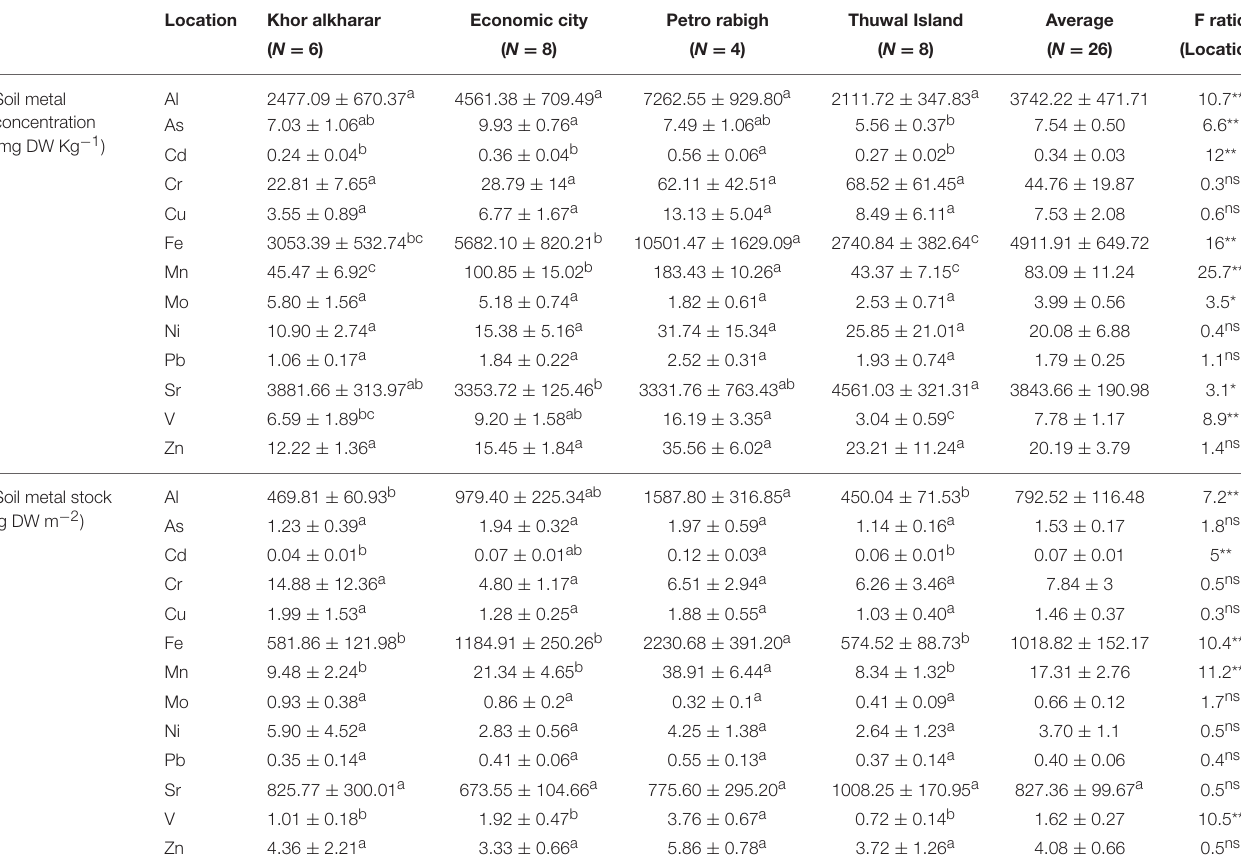
TABLE 3 | Mean ± SE of metal concentrations (mg DW Kg − 1 ) and accumulated stock (g m − 2 ) in the top 30cm of the soil from four different locations in the Central Red Sea, and the results from ANOVA Tukey HSD post-hoc tests for differences among locations.